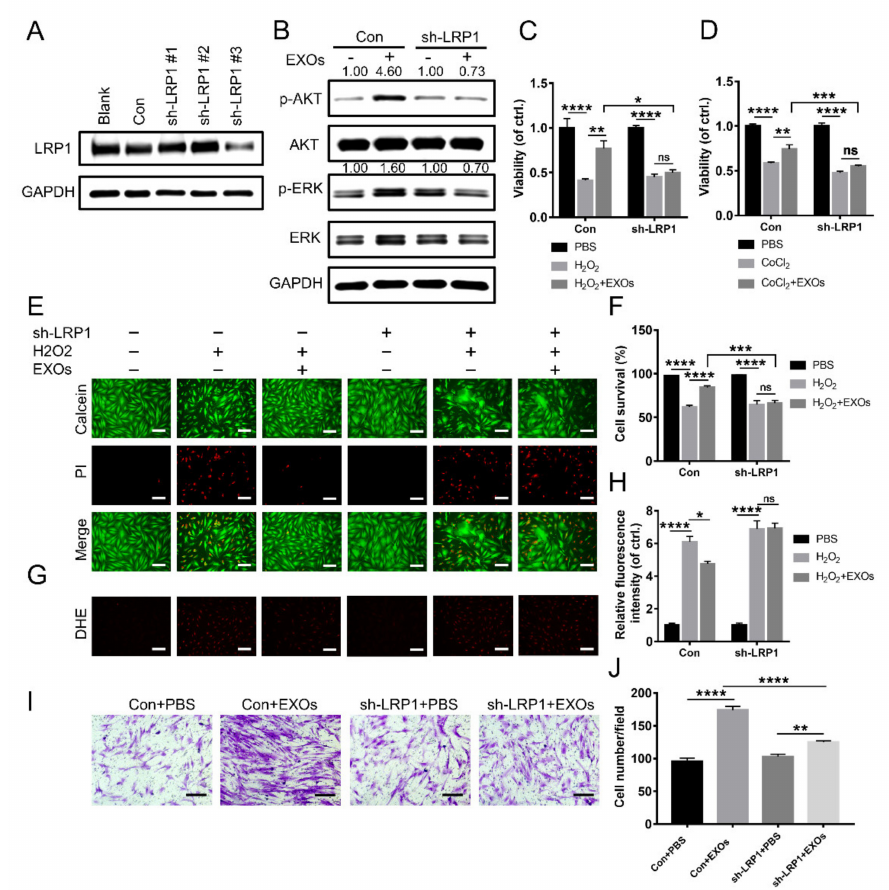
Figure 5. ADSC-EXOs regulated cell function via binding to the receptor LRP1 on fibroblasts. ( A ) Western blot analysis of the gene-silencing efficiency of sh-LRP1 lentivirus vectors ( n = 3). ( B ) Western blot analysis of the activation of AKT and ERK pathways in control and LRP1 knockdown fibroblasts after the EXOs treatment ( n = 3). Control and LRP1 knockdown fibroblasts were pre-treated with ADSC-EXOs or PBS for 24 h, then exposed under H 2 O 2 for 6 h or CoCl 2 for 24 h, and finally assessed by the following assays. ( C ) CCK8 analysis of the cell viability of fibroblasts under H 2 O 2 exposure. ( D ) CCK8 analysis of the cell viability of fibroblasts under CoCl 2 exposure. ( E ) Evaluation of the fibroblasts viability by Calcein-AM/PI staining. ( F ) Quantitative analysis of the data in ( E ). ( G ) Representative DHE fluorescent images of fibroblasts in each group. ( H ) Quantitative analysis of the relative fluorescence intensity in ( G ). ( I ) Representative micrographs of migratory fibroblasts after the EXOs treatment. ( J ) Quantitative analysis of the data in ( I ). n = 5. Scale bar: 100 µ m. * p < 0.05, ** p < 0.01, *** p < 0.001, **** p <